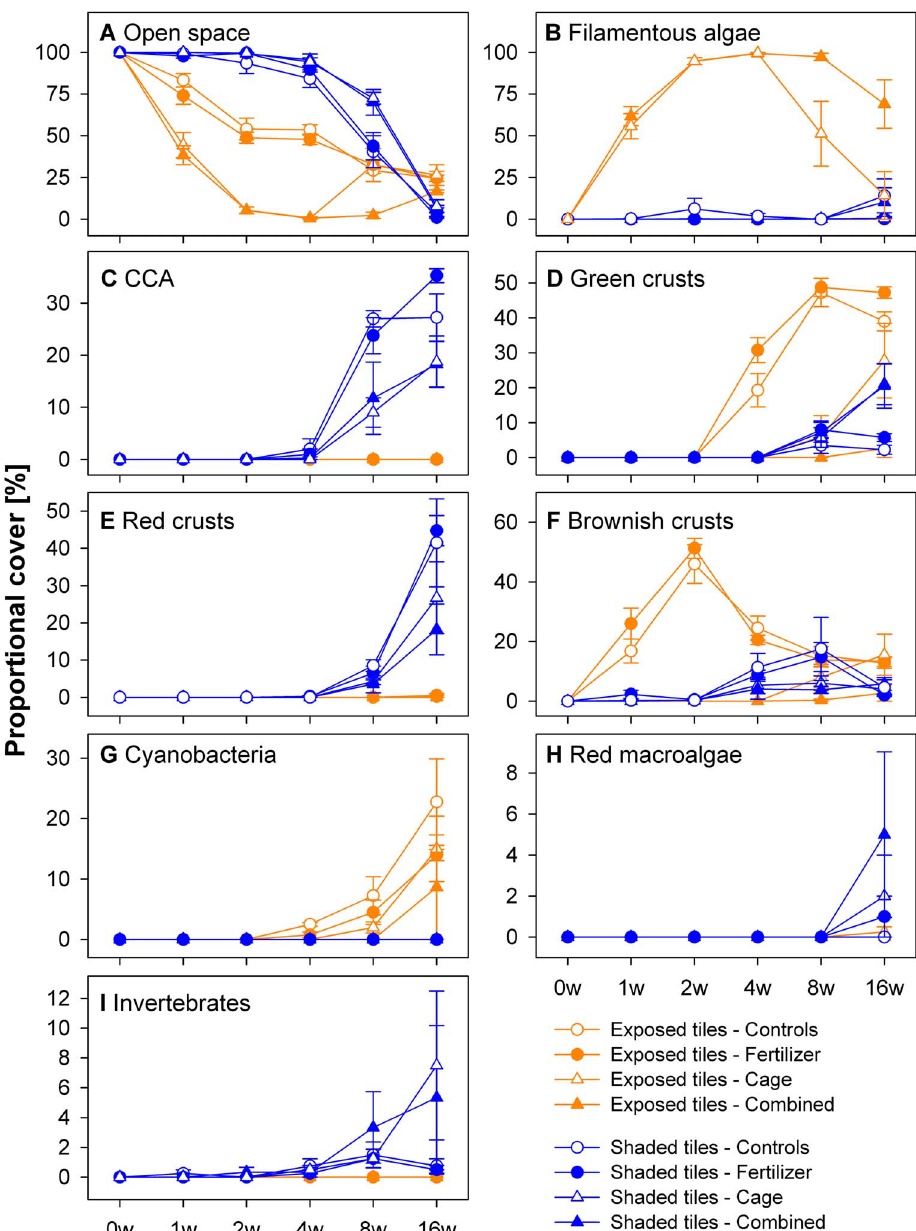
Figure 4. Percent cover of functional groups on light-exposed (orange) and shaded tiles (blue). Shown is the proportional cover (means 6 SE) over the study period of 4 months of functional groups in the 4 treatments: control, fertilizer, cage, and combined. See Tables 3 and 4 for statistical results.